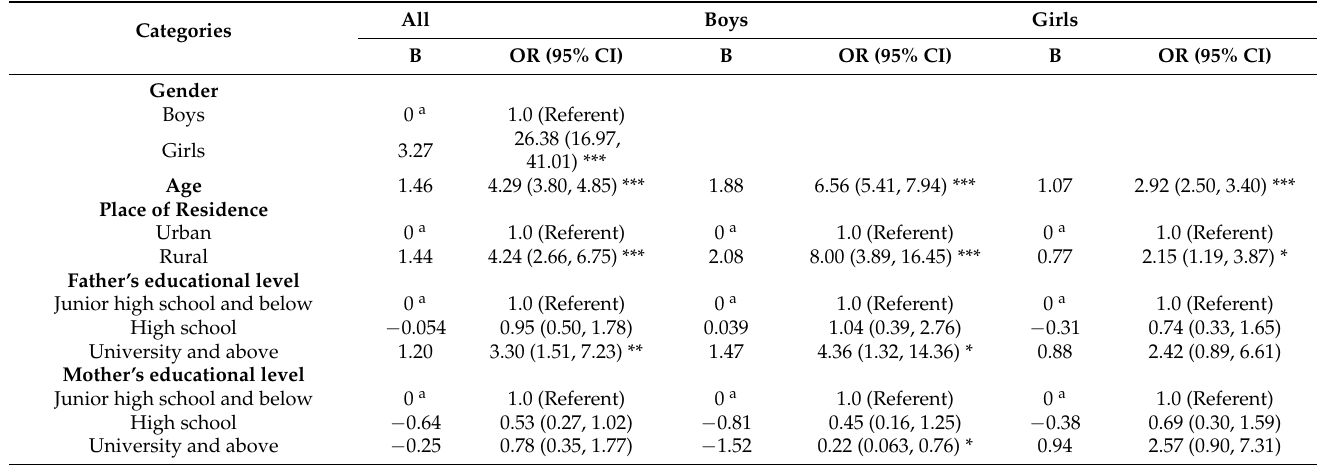
Table 4. Variables predicting PF score: results of multiple linear regression models.